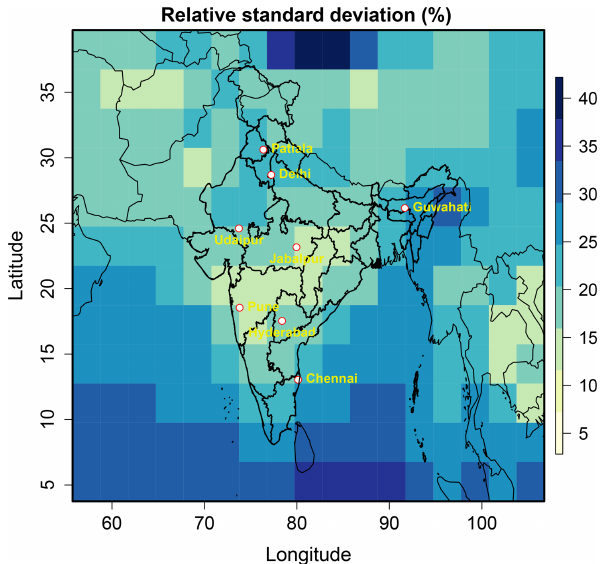
Figure 4. Relative standard deviation of surface ozone from the eight models. The plot also shows the location of ground-based ob- servational MAPAN stations considered in this